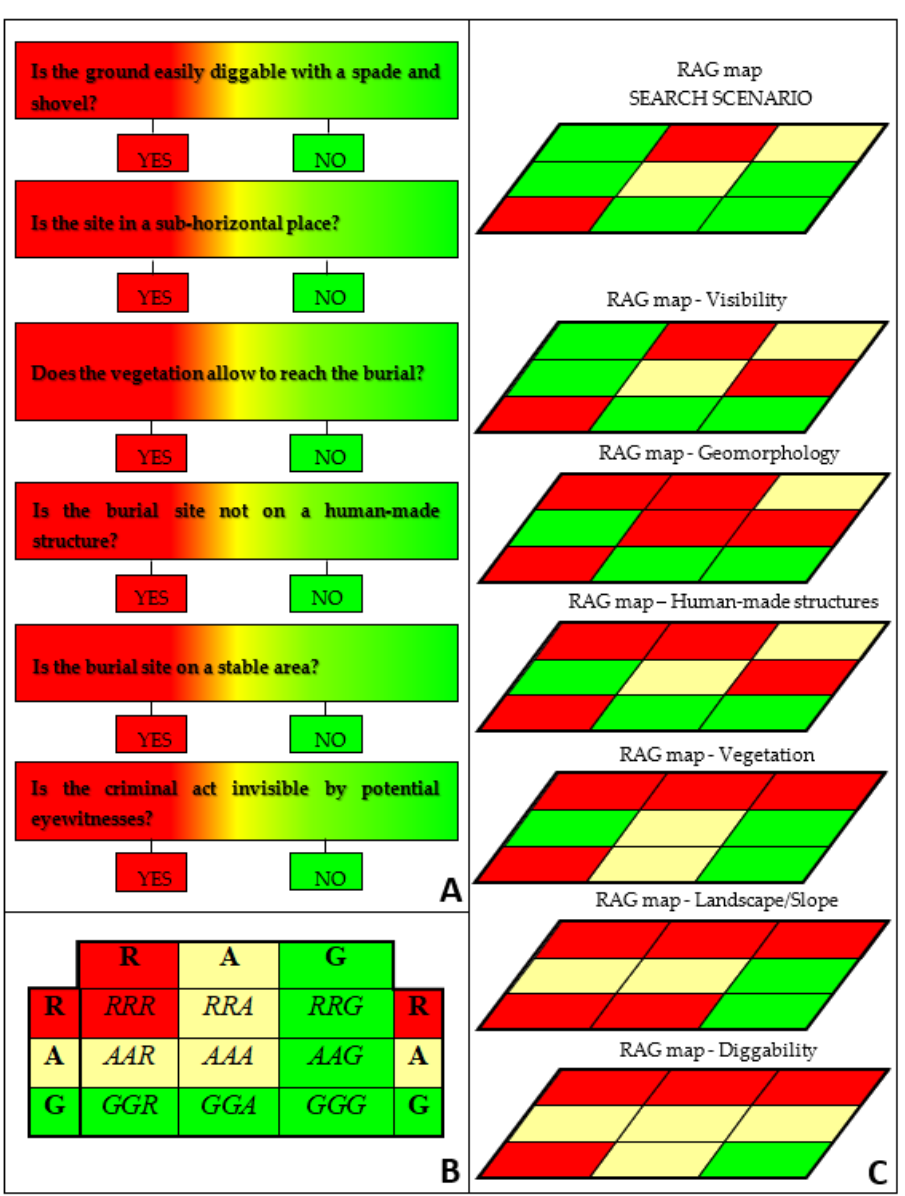
Figure 1. RAG color coded system applied to the search for clandestine graves and adopted in the present research. ( A ) RAG system conceptual model. For each question related to the considered factor: a positive answer means that the place is suitable for hosting a burial, and consequently, it indicates a site at high priority of search (assigned to Red-code); a negative answer means that it is not suitable for hosting a burial and consequently it indicates a site at low priority of search (assigned to Green-code). ( B ) An example of color-code matrix to explain the method for assigning RAG color-codes to each area of the RAG map. ( C ) Scheme based on the conceptual model ( A ) for constructing the RAG map search scenarios. The search scenario is obtained crossing geographical information from the RAG maps related to the six suitable factors.